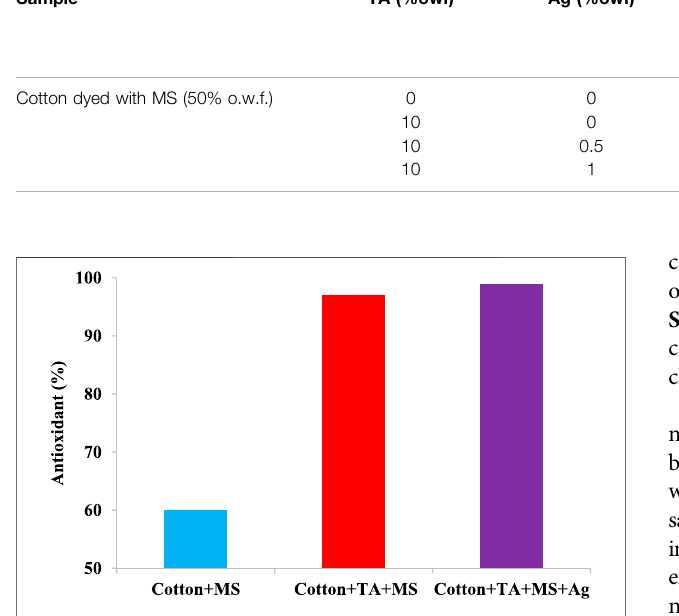
TABLE 7 | The antibacterial activity of dyed cotton fabrics with MS after 5 and 10 washes. Sample TA (%owf)